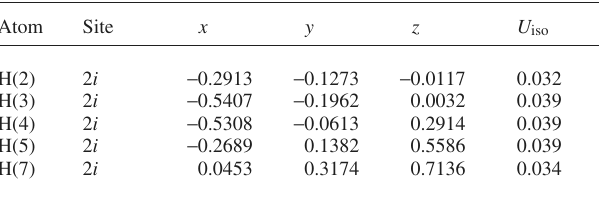
Table 2. Atomic coordinates and displacement parameters (in Å 2 )